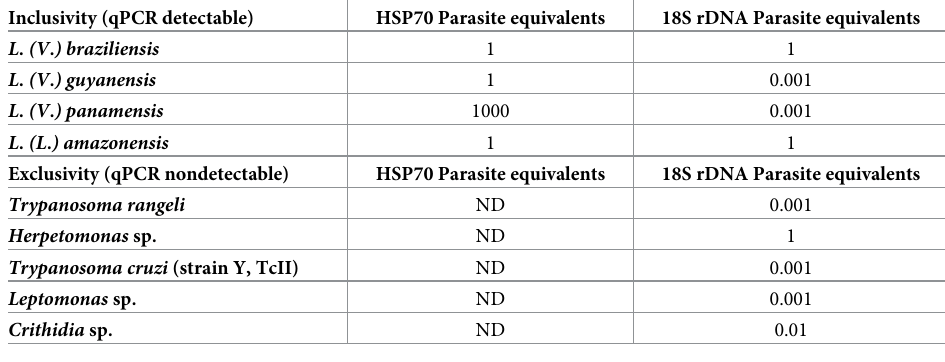
Table 3. Inclusivity assay for Leishmania species and Exclusivity assay for other trypanosomatids. Inclusivity (qPCR detectable) HSP70 Parasite equivalents 18S rDNA Parasite